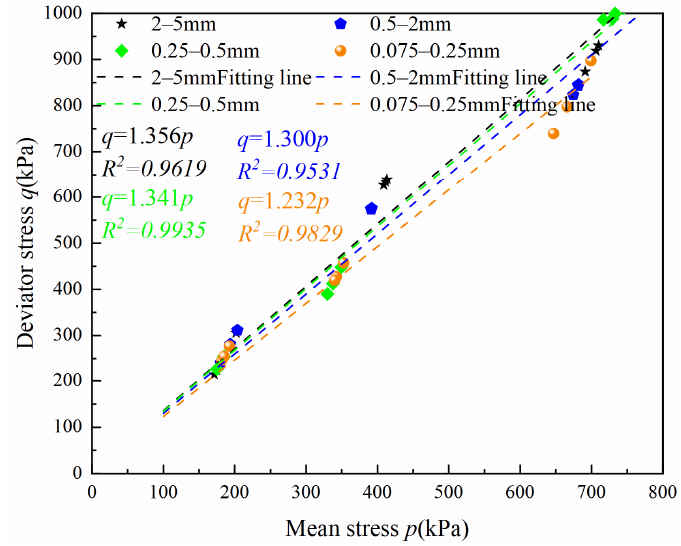
Figure 12. Critical state lines of volcanic soil with different particle sizes on deviator stress and mean stress plane.